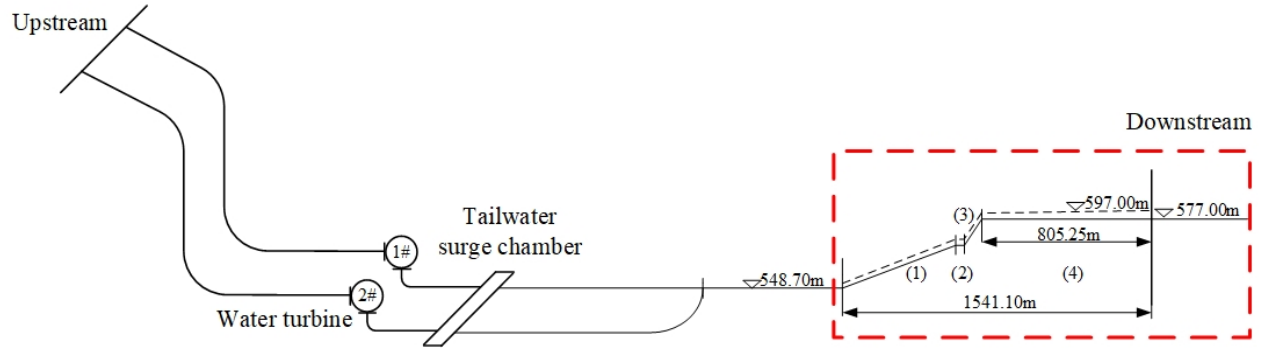
Figure 1. The layout of the water conveyance system of a hydropower station. Table 1. Tunnel parameters.